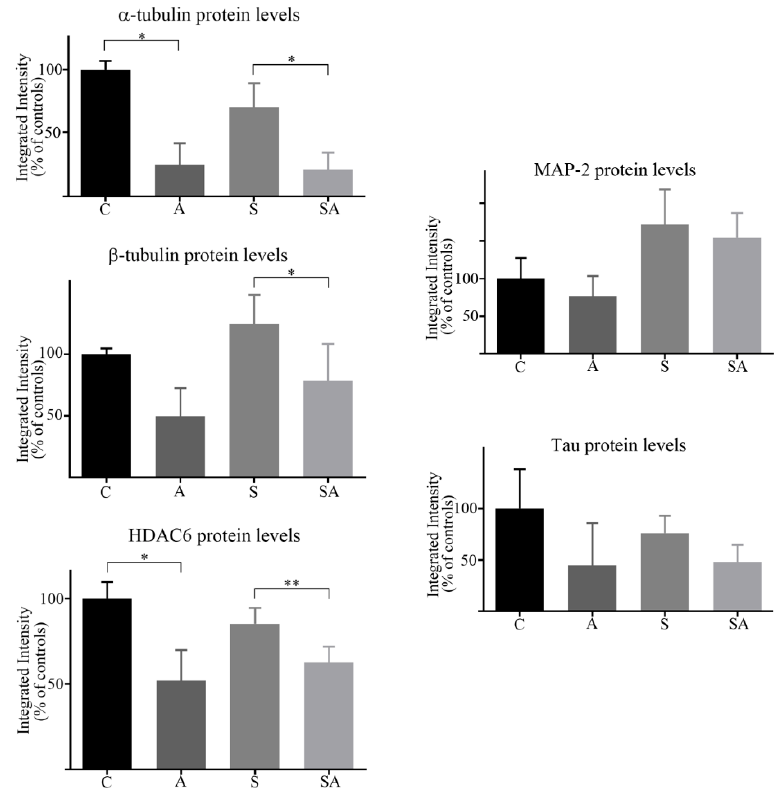
Figure 3. Quantitation of Western blots. Western blots of proteins from control (C), alcoholic (A), suicide (S), and suicide alcoholic (SA) patients were quantified using densitometry, with GAPDH levels used for blot normalization. Histograms are representative of means ± standard deviation, n = 9–11. For marked significance: * = p < 0.05, ** = p < 0.01. Control values were set at 100%.